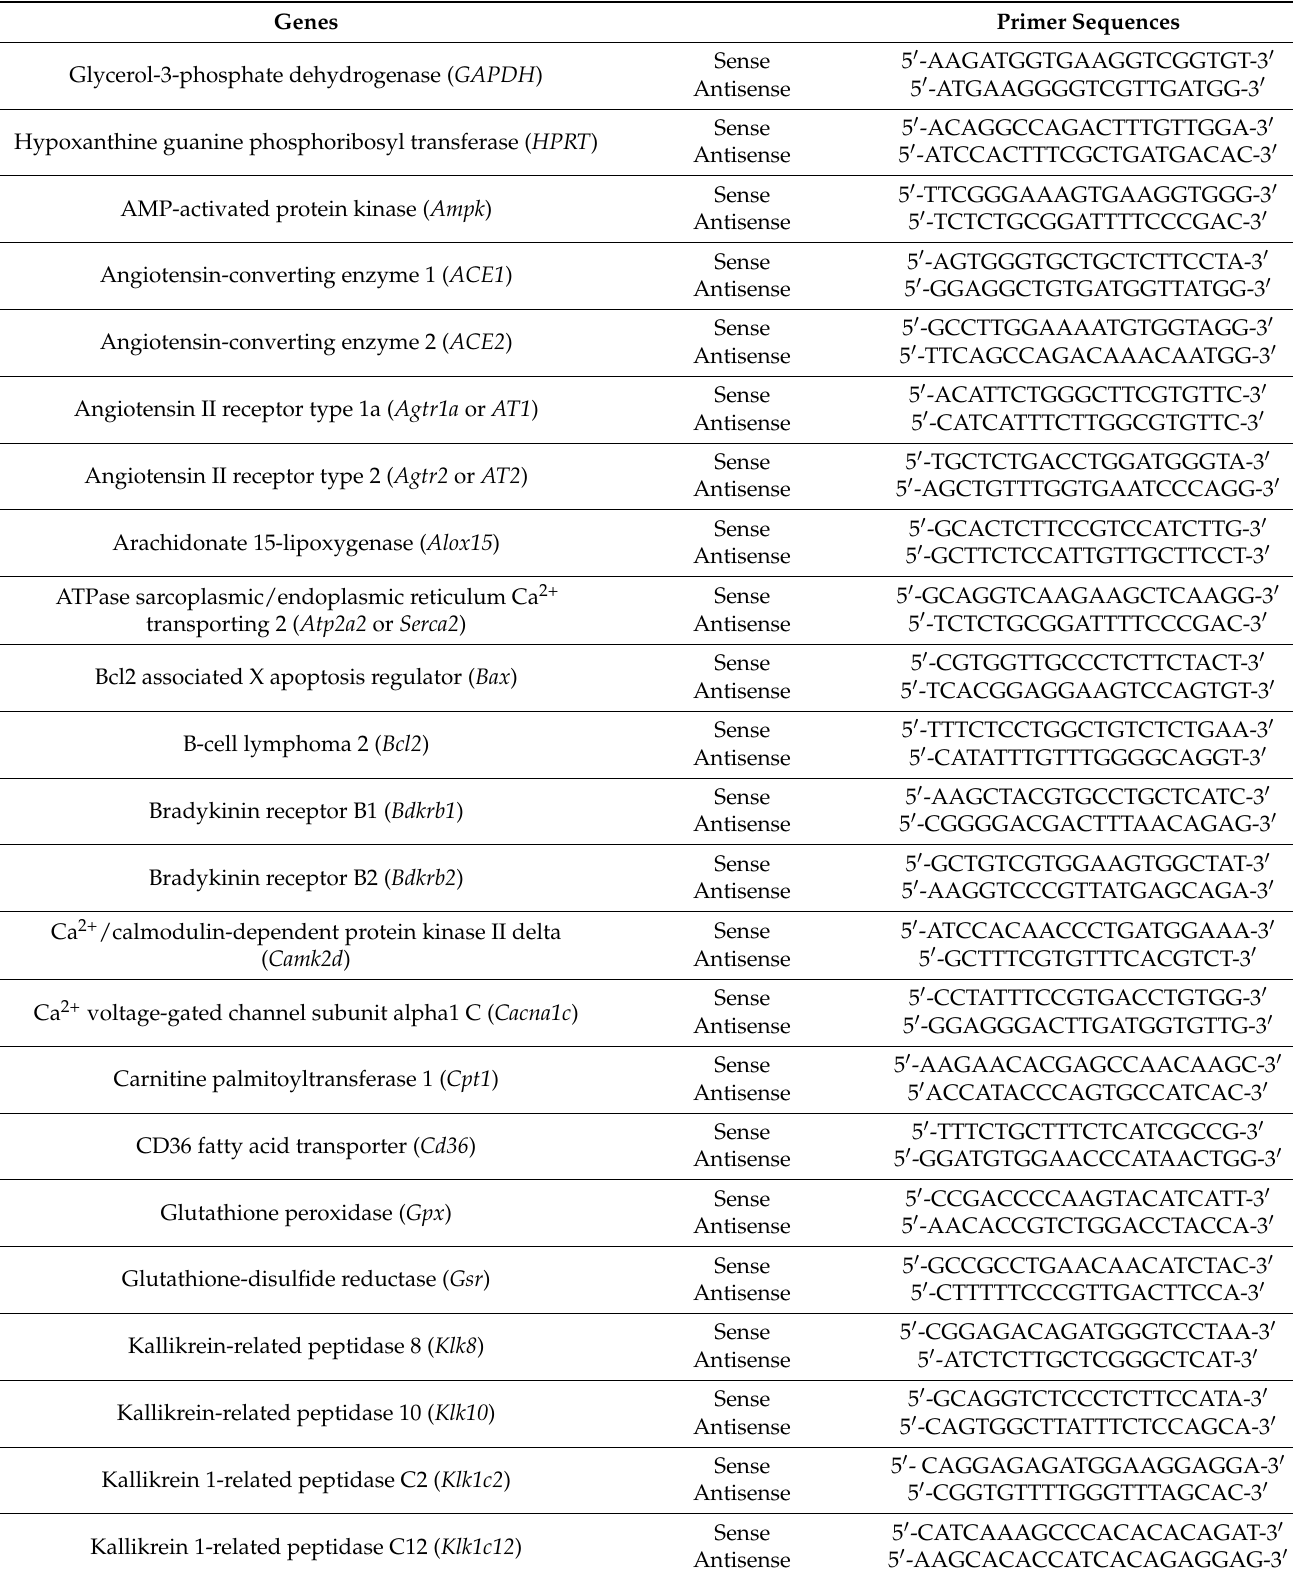
Table 1. Primers used for real-time quantitative polymerase chain reaction ( RTq-PCR ) in rat left ventricular (LV) myocardial